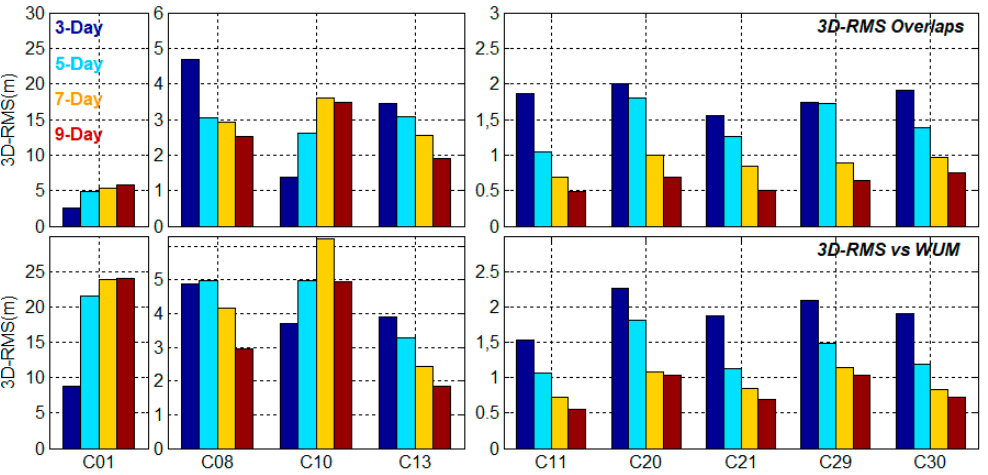
Figure 15. The overall average 3D-Root Mean Square (RMS) of SLR-only orbit determination for BDS satellites. Table 5. The minimum and maximum values of 3D-RMS for BDS satellites (Unit: